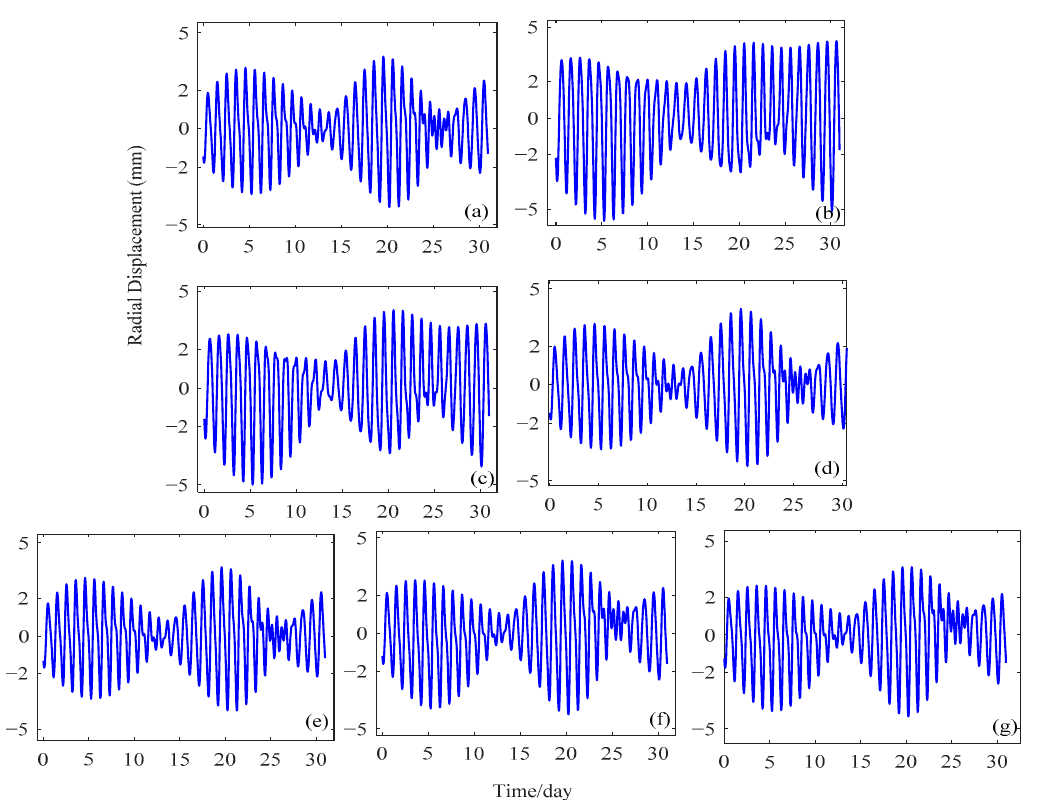
Figure 3. The magnitudes of the vertical OTL displacements at the inland station NOVM (Novosibirsk, Russia), determined using different OTL models: ( a ) DUT10, ( b ) EOT11a, ( c ) FES2004, ( d ) GOT4.7, ( e ) Hamtide11a, ( f ) Nao.99b and ( g ) TPXO7.2.